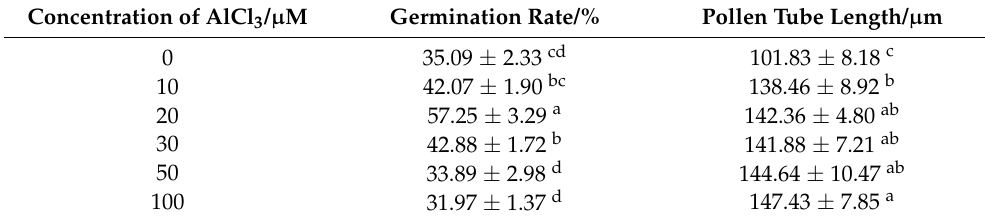
Table 1. Germination rate and length of pollen tubes under different concentrations of AlCl 3